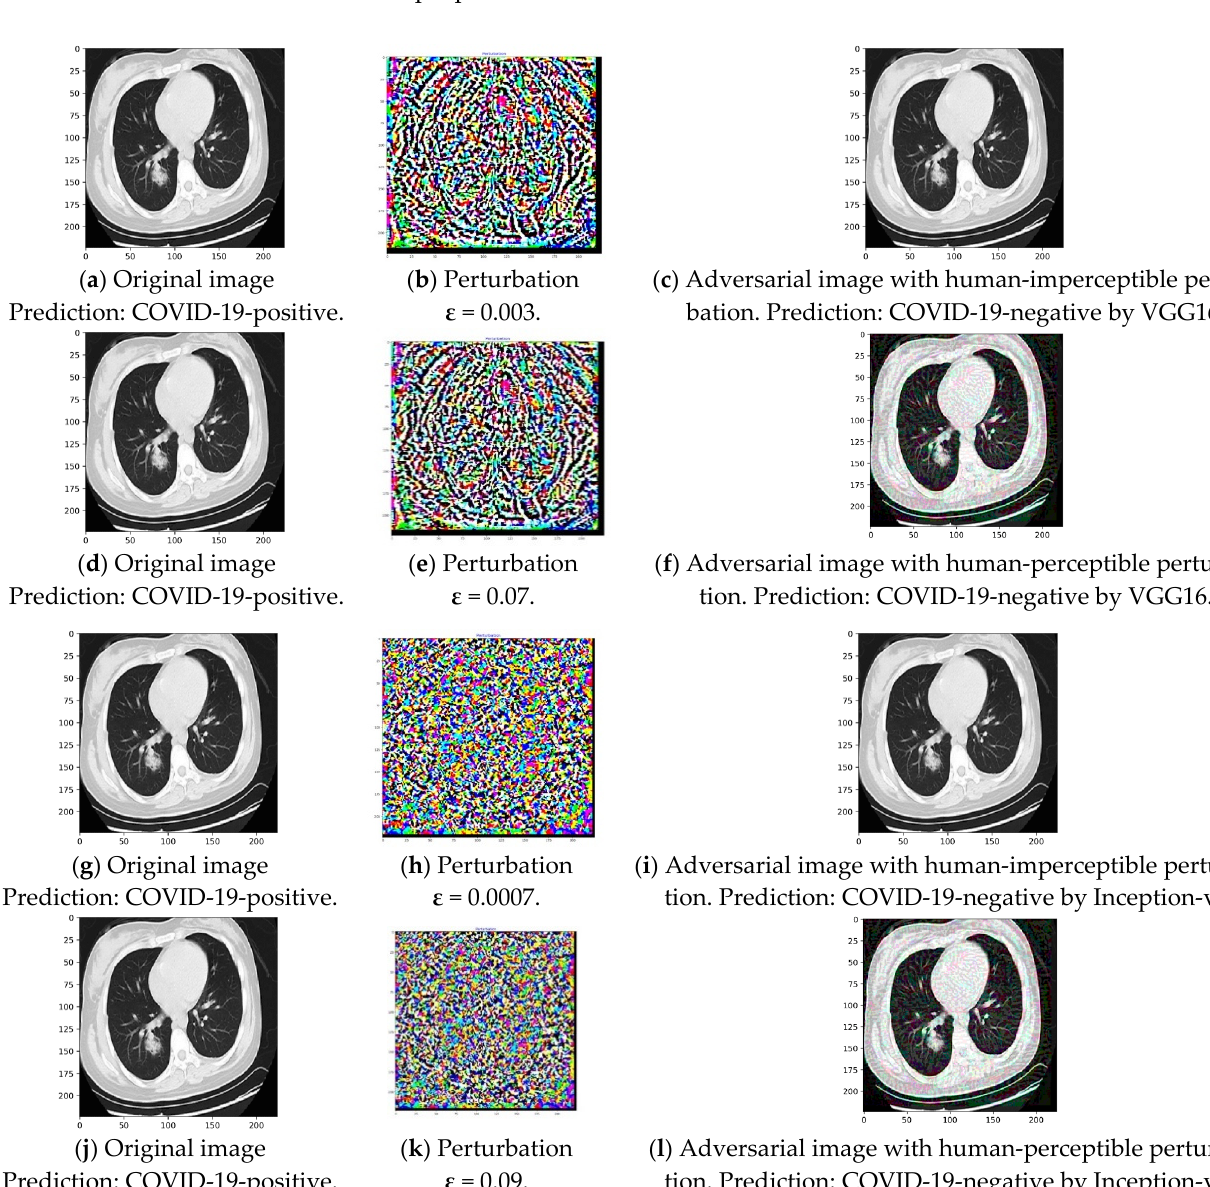
( b ) Inception-v3. Figure 12. Performance for different ε of FGSM attack in chest CT images.